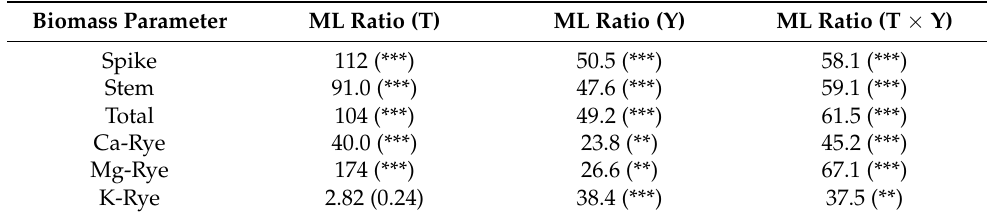
Table 2. Analysis of variance performed on the biomass parameters (spike, stem and total biomass; Ca, Mg and K content in stems) at the harvest stage. The variability in the biomass parameters was evaluated using the hierarchical multilevel model (maximum likelihood (ML) ratio). The results were significant at ** p < 0.01 and *** p <